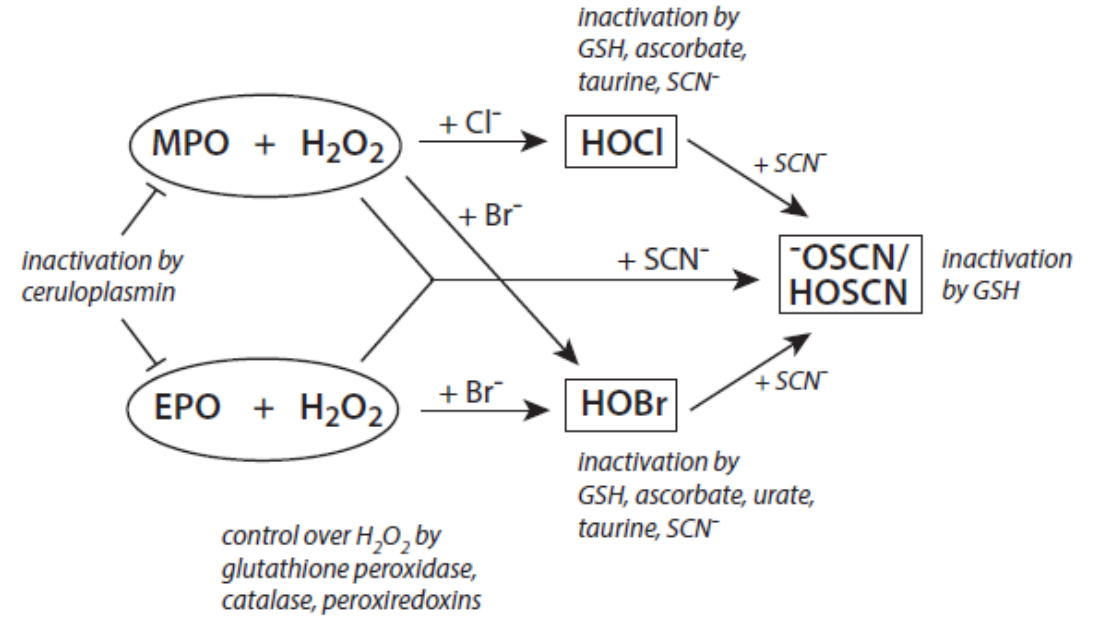
Figure 3. Major antagonizing principles controlling the halogenation activity of MPO and EPO at inflammatory sites. Explanations are given in the text.